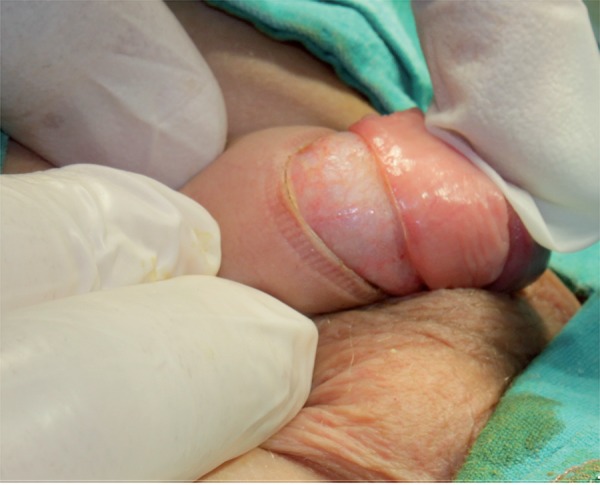
Image obtained after laser excision.